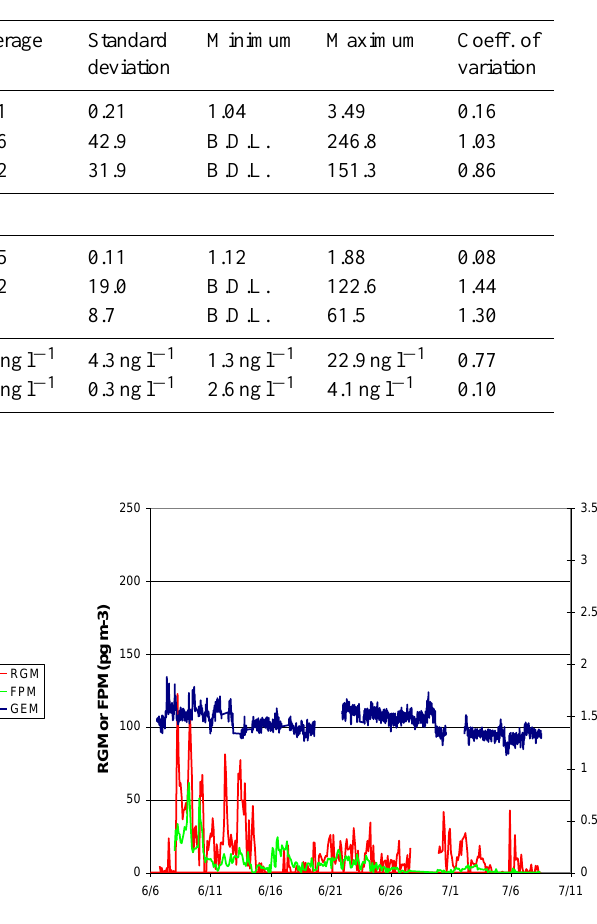
Fig. 1. All atmospheric mercury speciation data from the 2007 cam- paign. The measured species are reactive gaseous mercury (RGM), fine particulate mercury (FPM), and gaseous elemental mercury (GEM).